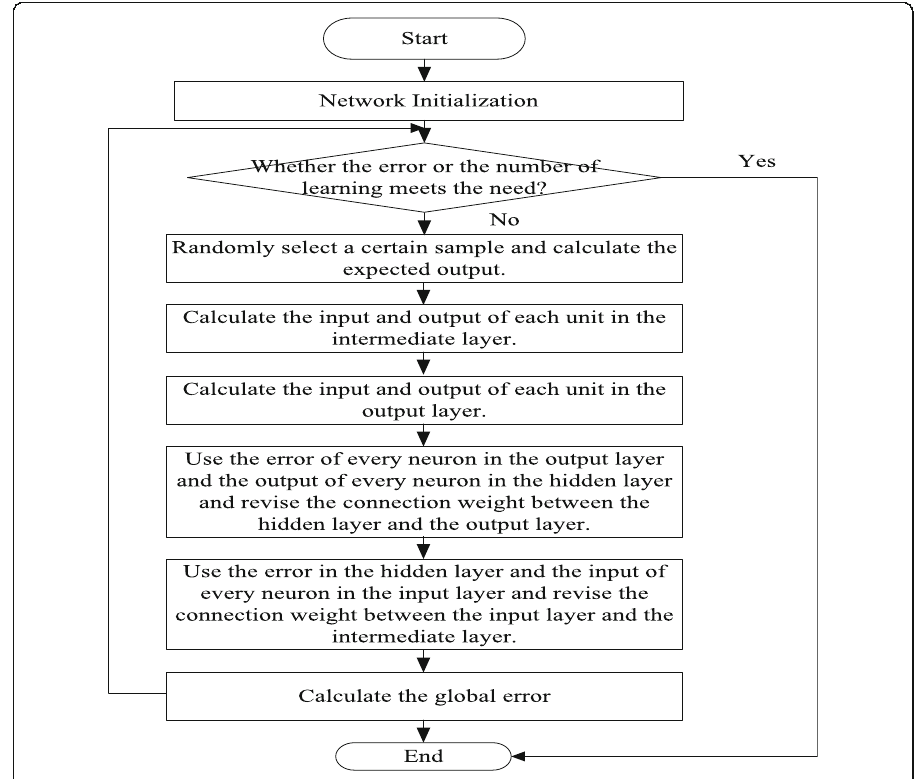
Fig. 2 Flowchart of BP neural network based on momentum-adaptive learning